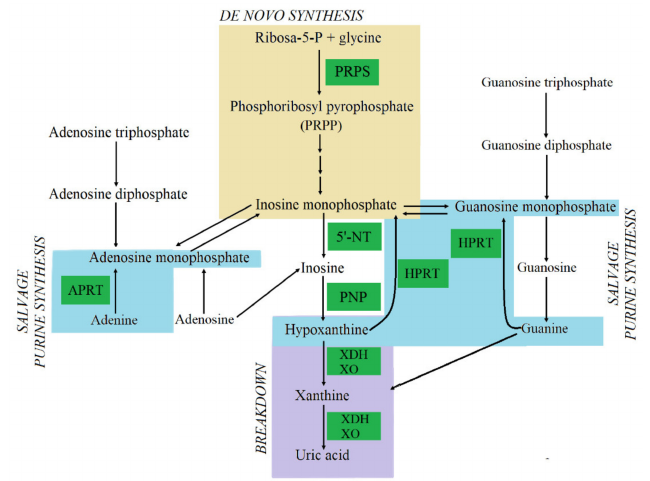
Figure 3. Purine metabolism includes three steps: de novo synthesis, salvage and breakdown pathways. The de novo synthesis is a multi-step process and requires the contribution of PRPS, four amino acids, one PRPP, two folates and three ATP to synthesise an inosine monophosphate (IMP). IMP may be directly catalysed into inosine by 5 (cid:48) -nucleotidases (5 (cid:48) NT), and then purine nucleoside phosphorylase (PNP) converts inosine into hypoxanthine. HPRT catalyses the salvage synthesis of inosine monophosphate (IMP) and guanosine monophosphate (GMP) from the purine bases hypoxanthine and guanine respectively, utilising PRPP as a co-substrate. The HPRT action causes the accumulation of hypoxanthine and guanine, which are converted into uric acid by XO and xanthine dehydrogenase (XDH) in the breakdown pathway. Additionally, APRT catalyses the salvage synthesis of adenosine monophosphate (AMP) and IMP adenine, utilising PRPP as a co-substrate [106]. A summary of purine metabolism enzymes associated with kidney stone development is presented in Table